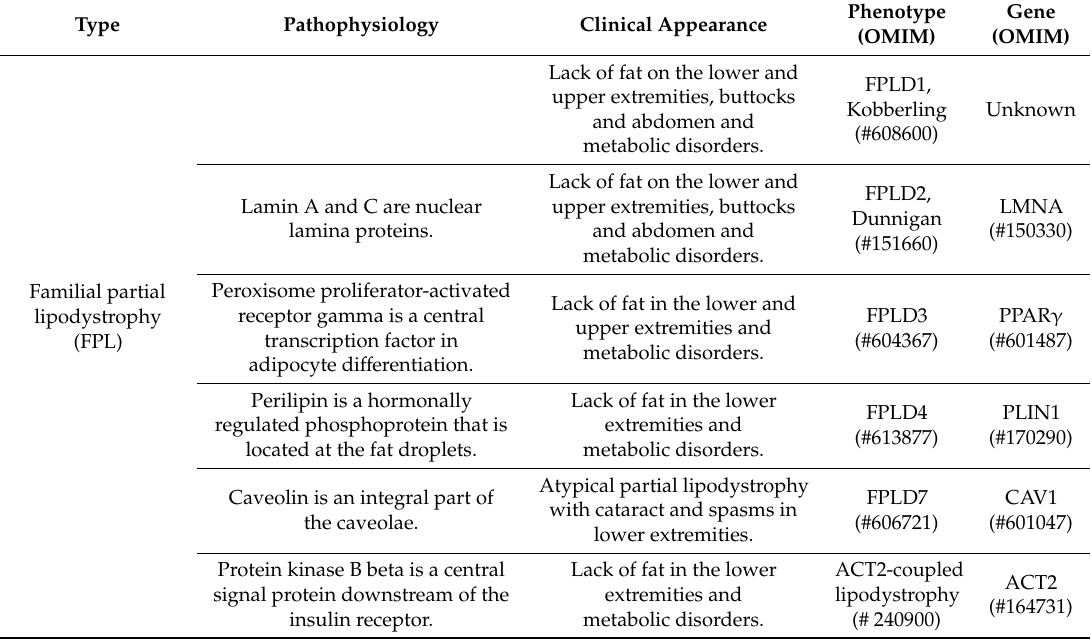
Table 2. Classification of autosomal dominant forms of